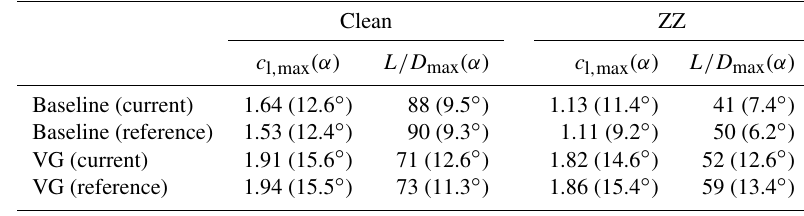
Table C1. DU97W300. Characteristic values. Reference data are adopted from Baldacchino et al. (2018).